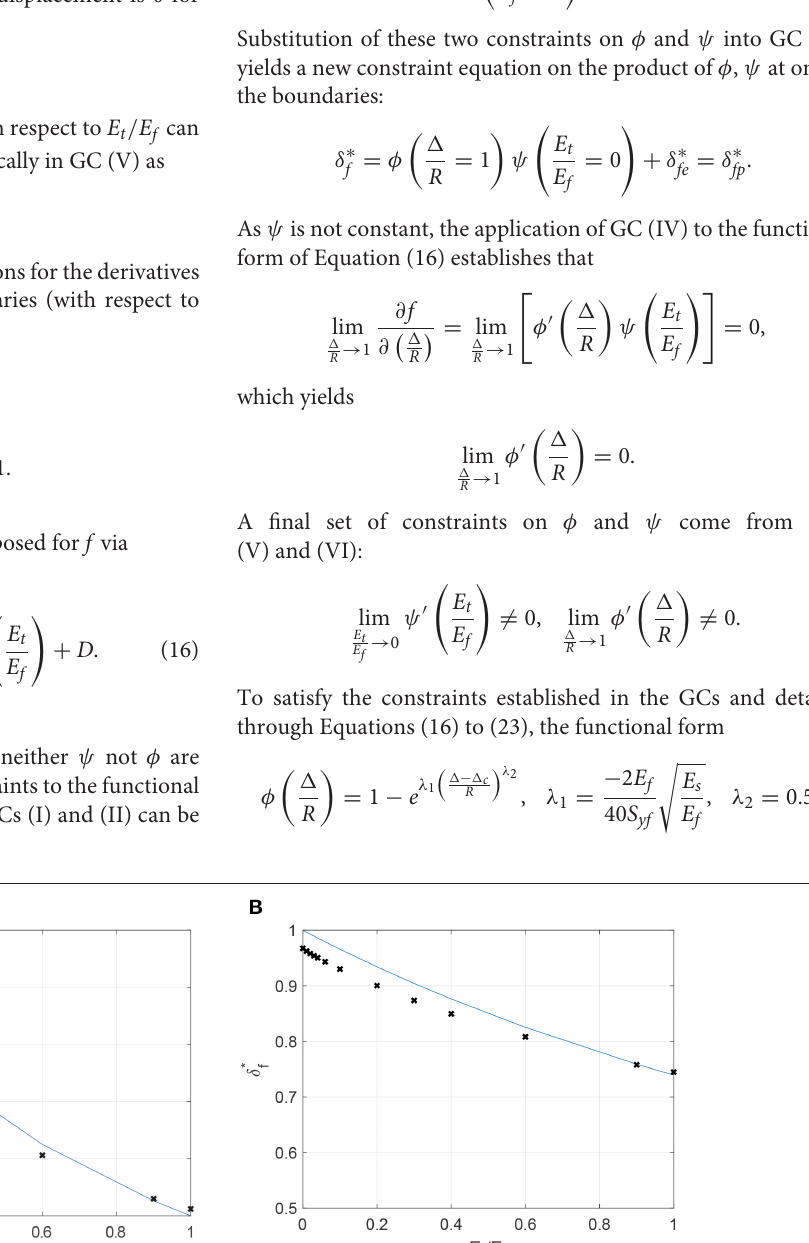
FIGURE 10 | Comparison of the FEA results (x) and the assumption of GC III at the large deformation limit ( 1/ R